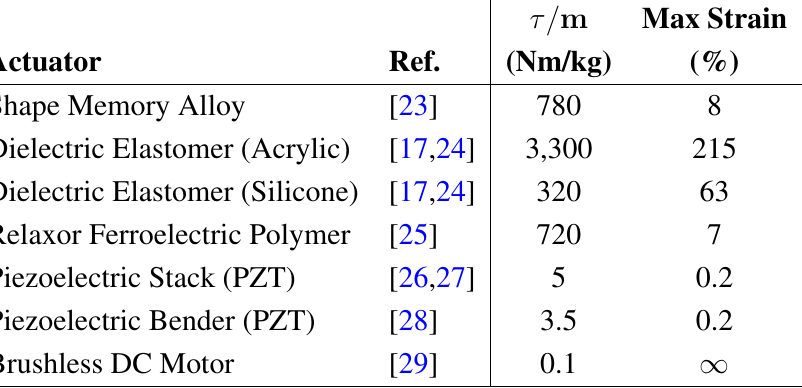
Table 1. Active material and electromagnetic performance